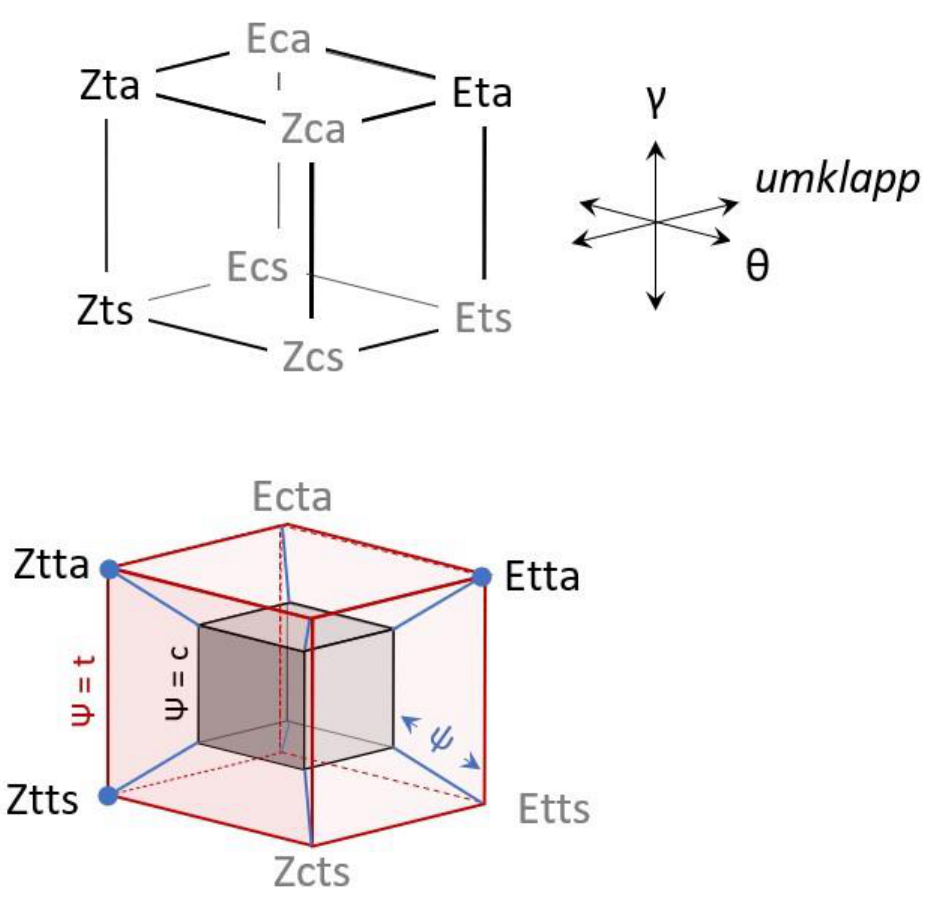
Figure 13. Schematic depiction of the isomer interconversion processes occurring in the chlorohydra-